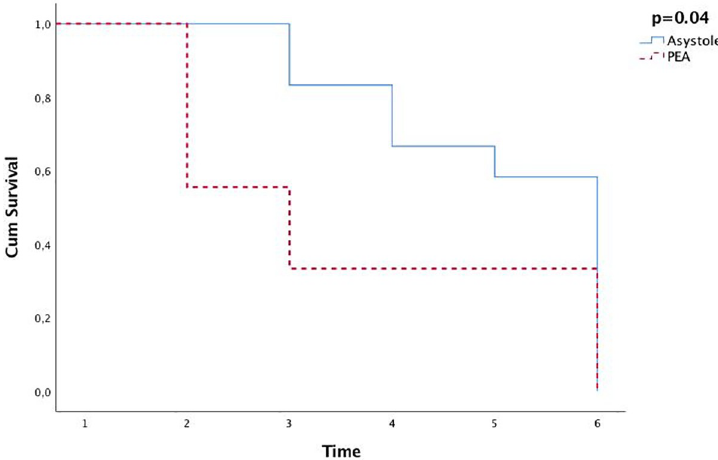
Fig 2. Kaplan–Meier survival graph for piglets with pulseless electrical activity (PEA) and asystole p = 0.04. 1 = start of experiment, 2 = CPR, 3 = 1h after return of spontaneous circulation (ROSC), 4 = 2h after ROSC, 5 = 3h after ROSC, 6 = 4h after